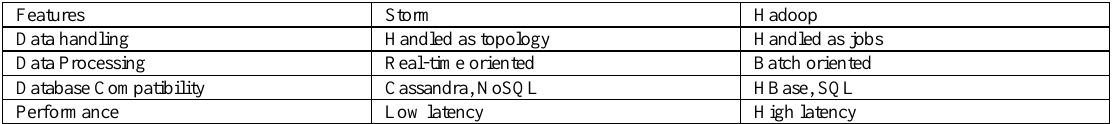
Table 5. A comparison of features between Storm and Hadoop (Vanathi and Khadir, 2017) Features